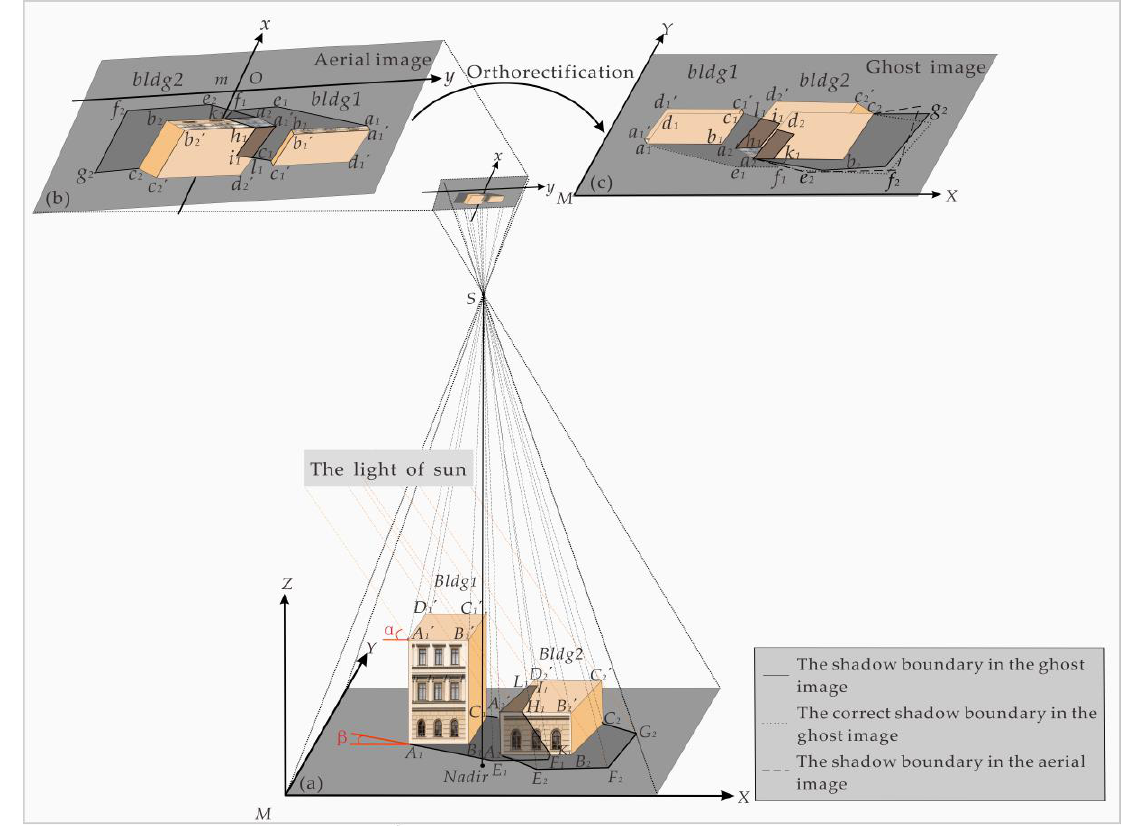
Figure 3. Relationship between the shadows in the aerial image and the ghost image. ( a ) DBM and shadow areas. ( b ) Image projected onto the image plane. ( c ) Ghost image after